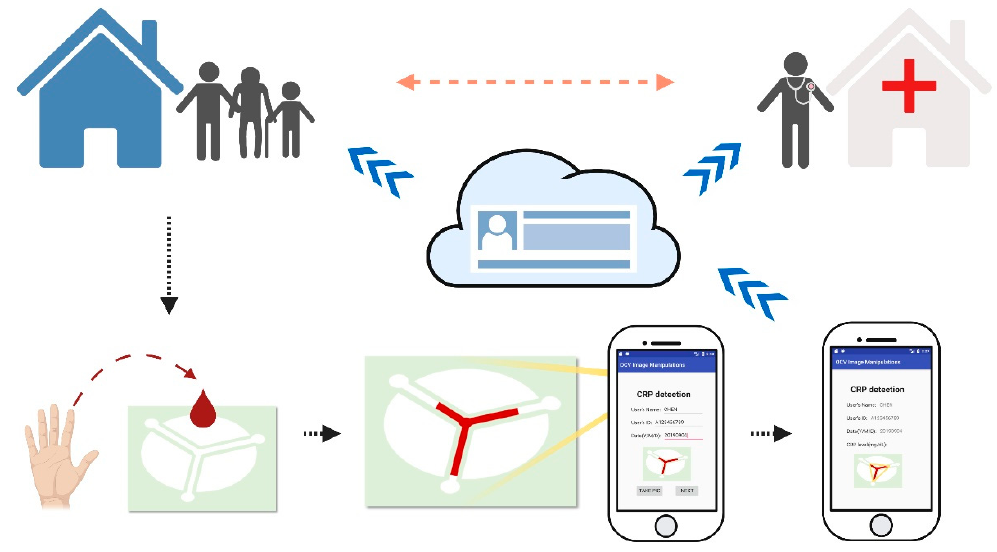
Figure 1. Schematic of the integration of point-of-care diagnostic tools and mobile devices. This figure presents the conceptual view of the clinical data flow of the point-of-care diagnostic tools and mobile devices in case of the C-reactive protein diagnosis that we have approached. Once the users place a drop of whole blood onto the diagnostic device, the whole blood would flow through the three channels. The users then could use the mobile application (APP) we have developed to take a picture